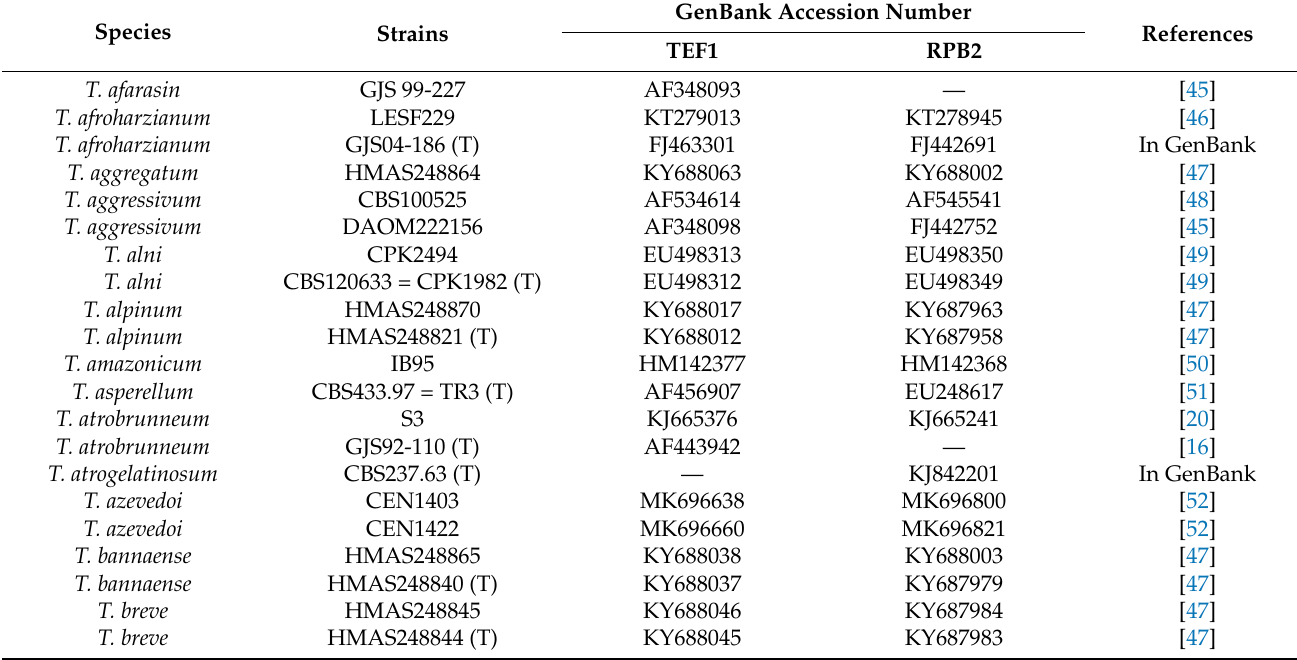
Table 1. Strain information and GenBank accession numbers of sequences used for phylogenetic analyses for new